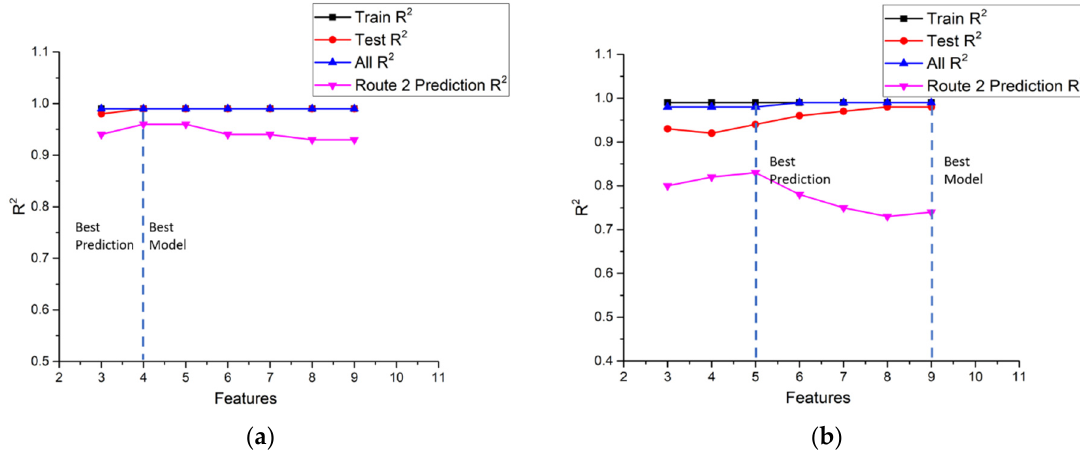
Figure 12. ( a ) Comparisons of the R 2 value of NO x models for the training sub-dataset, the test sub-dataset, all data, and the route 2 prediction in highway; ( b ) Comparisons of the R 2 value of CO 2 models for the training sub-dataset, the test sub-dataset, all data, and the route 2 prediction in highway. Table 13. Input number of features for best model and best prediction.